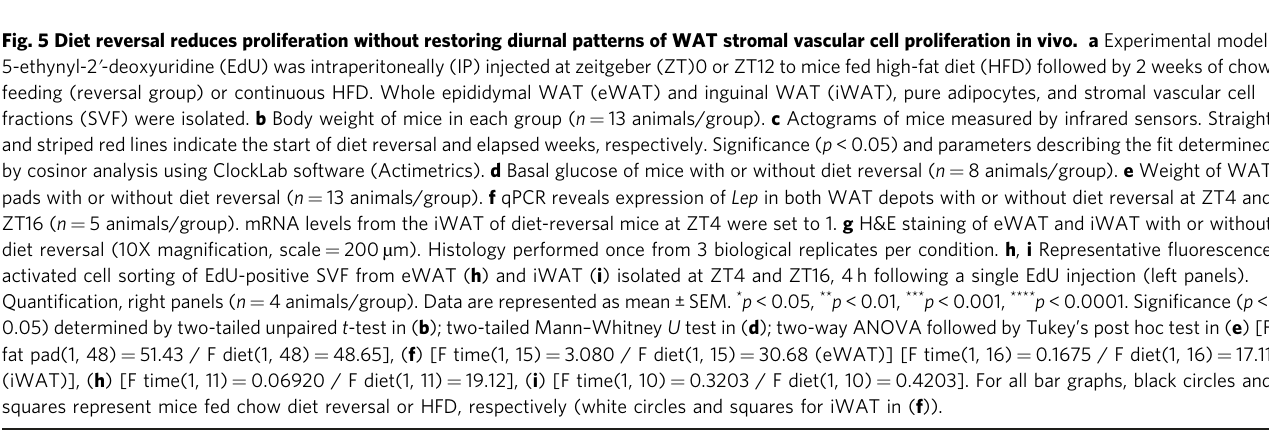
Fig. 5 Diet reversal reduces proliferation without restoring diurnal patterns of WAT stromal vascular cell proliferation in vivo. a Experimental model: 5-ethynyl-2 ʹ -deoxyuridine (EdU) was intraperitoneally (IP) injected at zeitgeber (ZT)0 or ZT12 to mice fed high-fat diet (HFD) followed by 2 weeks of chow feeding (reversal group) or continuous HFD. Whole epididymal WAT (eWAT) and inguinal WAT (iWAT), pure adipocytes, and stromal vascular cell fractions (SVF) were isolated. b Body weight of mice in each group ( n = 13 animals/group). c Actograms of mice measured by infrared sensors. Straight and striped red lines indicate the start of diet reversal and elapsed weeks, respectively. Signi fi cance ( p < 0.05) and parameters describing the fi t determined by cosinor analysis using ClockLab software (Actimetrics). d Basal glucose of mice with or without diet reversal ( n = 8 animals/group). e Weight of WAT pads with or without diet reversal ( n = 13 animals/group). f qPCR reveals expression of Lep in both WAT depots with or without diet reversal at ZT4 and ZT16 ( n = 5 animals/group). mRNA levels from the iWAT of diet-reversal mice at ZT4 were set to 1. g H&E staining of eWAT and iWAT with or without diet reversal (10X magni fi cation, scale = 200 µ m). Histology performed once from 3 biological replicates per condition. h , i Representative fl uorescence activated cell sorting of EdU-positive SVF from eWAT ( h ) and iWAT ( i ) isolated at ZT4 and ZT16, 4 h following a single EdU injection (left panels). Quanti fi cation, right panels ( n = 4 animals/group). Data are represented as mean ± SEM. * p < 0.05, ** p < 0.01, *** p < 0.001, **** p < 0.0001. Signi fi cance ( p < 0.05) determined by two-tailed unpaired t -test in ( b ); two-tailed Mann – Whitney U test in ( d ); two-way ANOVA followed by Tukey ’ s post hoc test in ( e ) [F fat pad(1, 48) = 51.43 / F diet(1, 48) = 48.65], ( f ) [F time(1, 15) = 3.080 / F diet(1, 15) = 30.68 (eWAT)] [F time(1, 16) = 0.1675 / F diet(1, 16) = 17.11 squares represent mice fed chow diet reversal or HFD, respectively (white circles and squares for iWAT in (